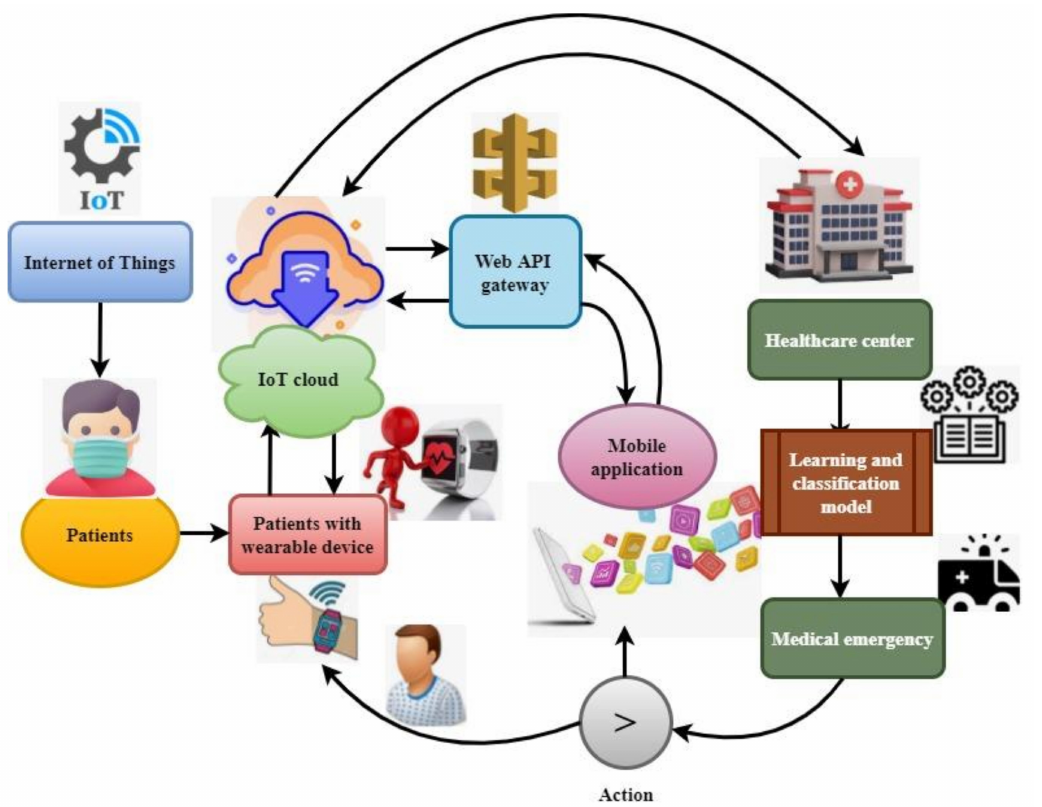
Figure 1. IoT with cloud involvement for the COVID-19